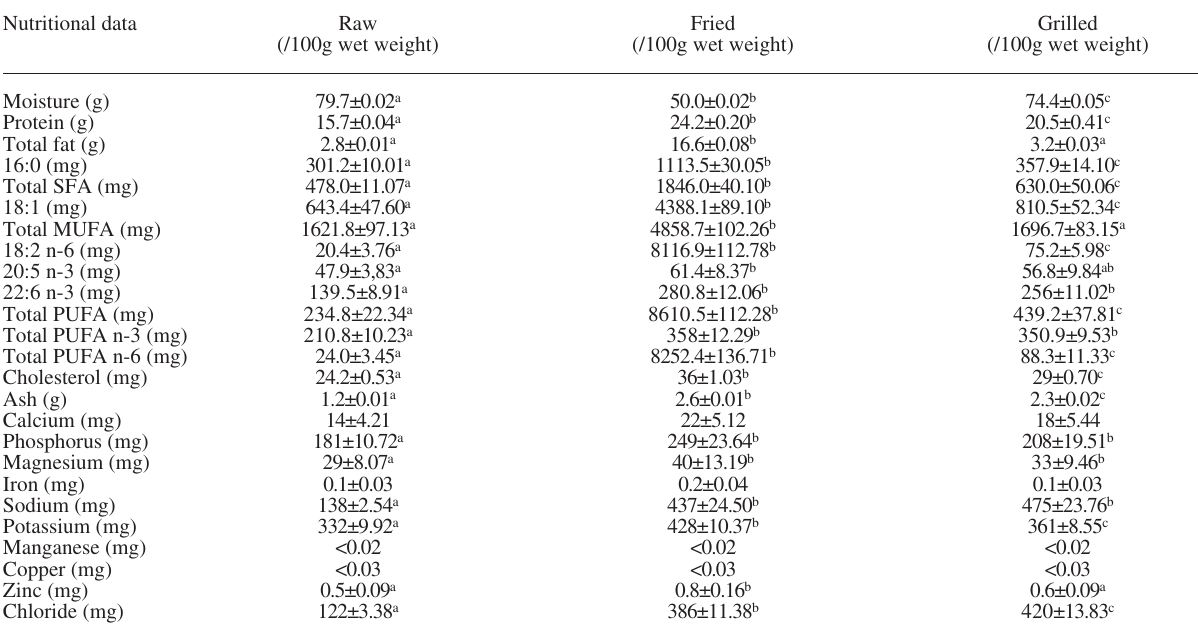
Table 5. – Nutritional data of raw, fried and grilled black scabbardfish (mean ± standard deviation). Nutritional